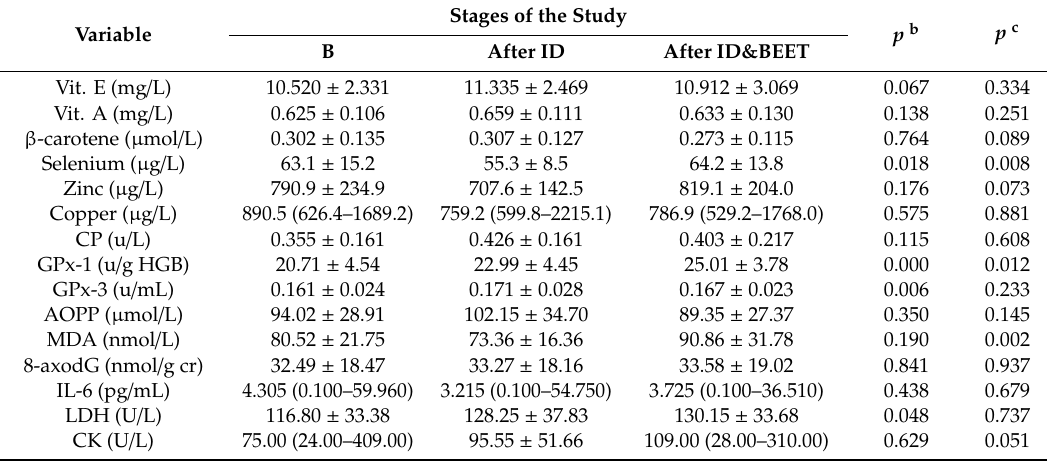
Table 3. Exogenous and endogenous antioxidants as well as biomarkers of inflammation, oxidative, and skeletal muscle damage in fencers (n = 20) participated in the study a